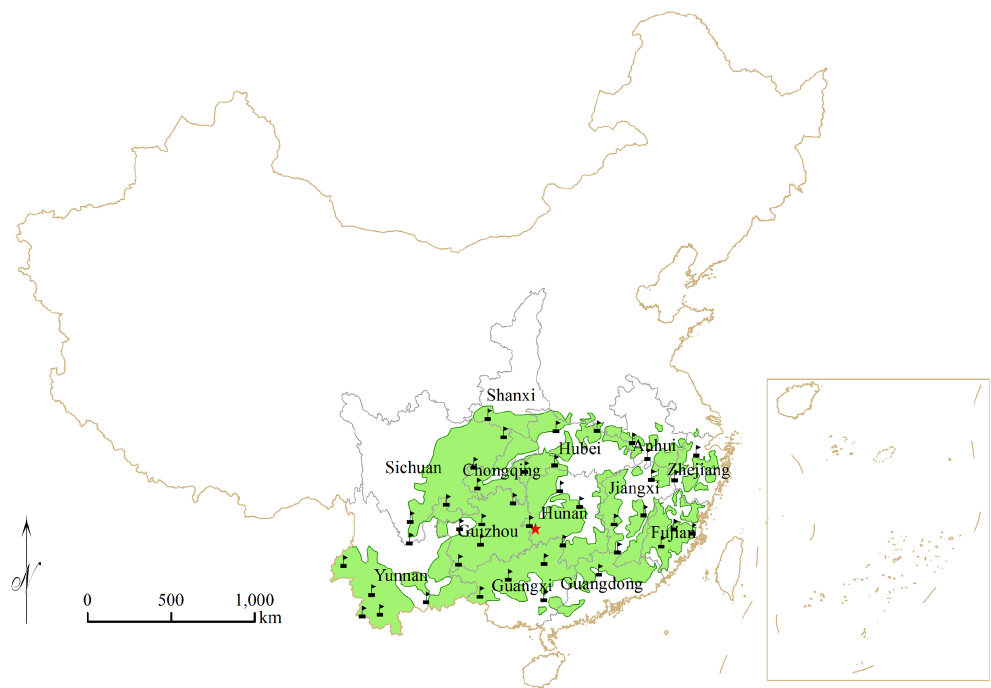
Figure 1. Location of the study area (green) in southern China. Names and borders of provinces are shown. Flags represent weather stations located within the study region. Red asterisk indicates Huitong county, which is the central place of Chinese fir production.